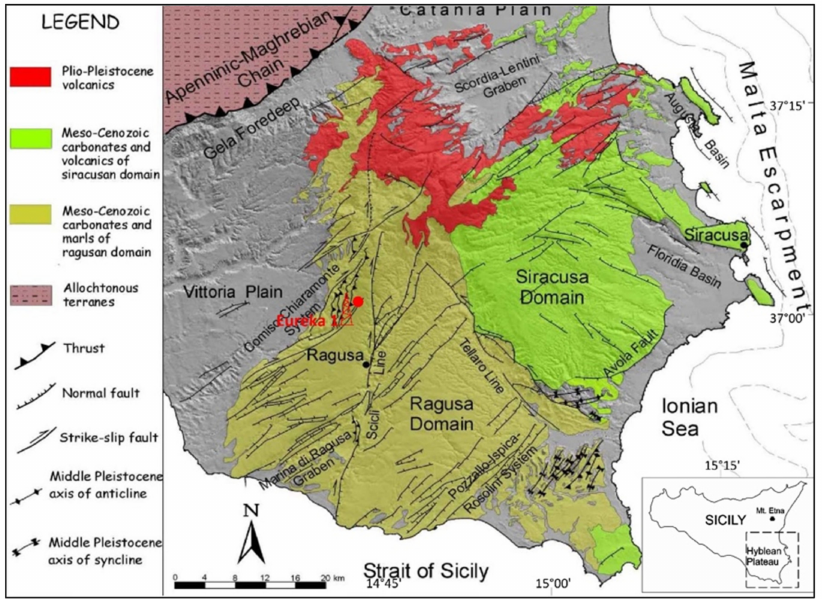
Figure 1. Geological-structural map of the Hyblean Plateau area modified after the works in [83,84] and location of the Eureka 1 well (red